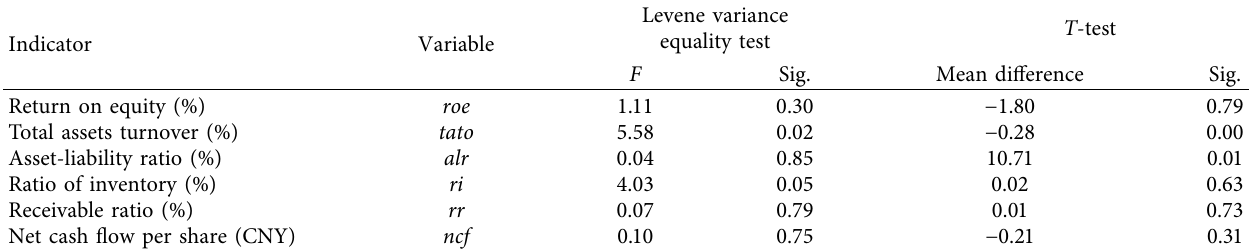
Table 5: Levene variance equality test and T -test of financial ratios.